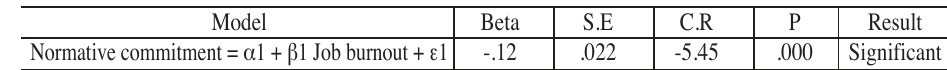
Job Burnout and Normative Commitment